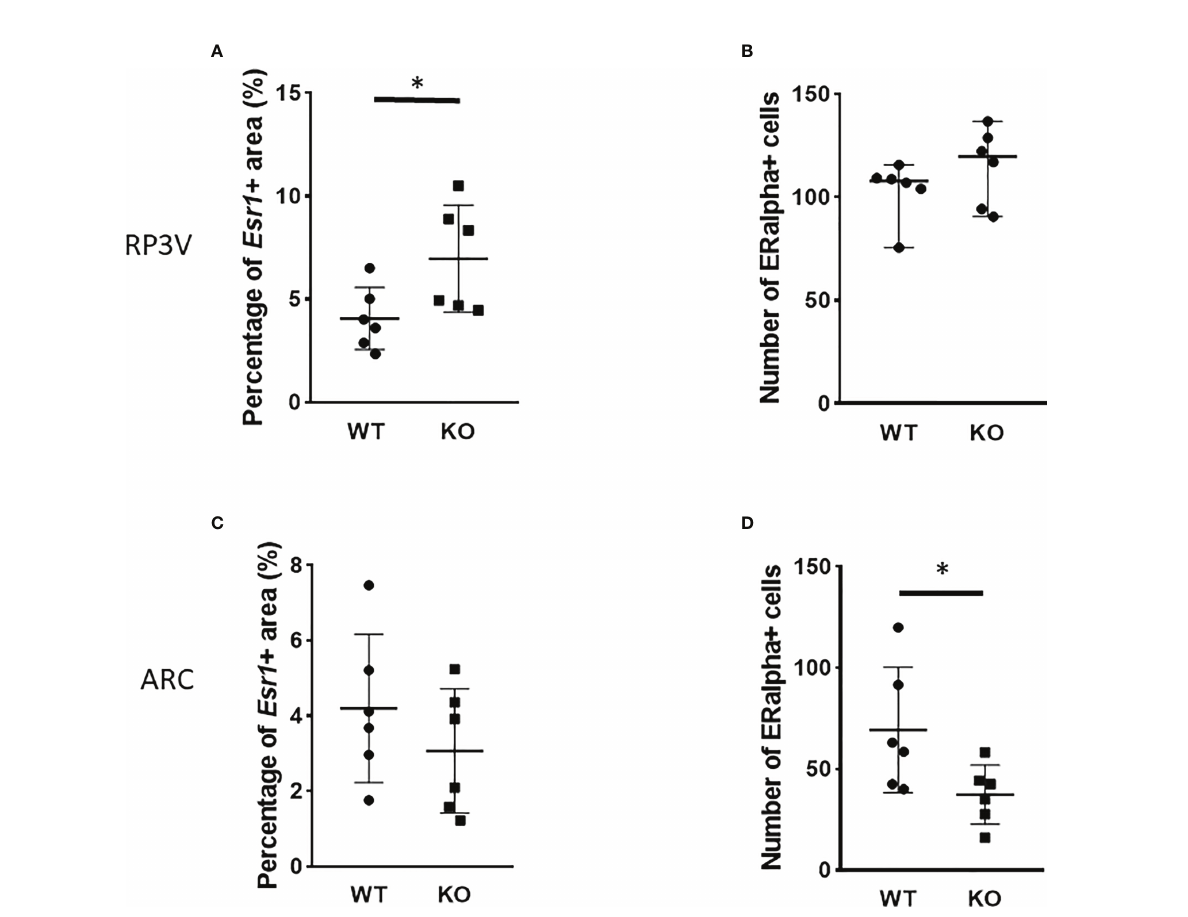
FIGURE 9 Number of ER a -immunoreactive cells in the RP3V and ARC in wild-type and PACAP KO female mice. Dot plots present the summarized data obtained by RNAscope in situ hybridization experiments showing Esr1 mRNA expression in RP3V (A) and ARC regions (C) . Immunohistochemical staining demonstrating ER a protein expression in RP3V (B) and ARC regions (D) . n = 6 – 6 animals for each group with two slices per animal. Graphs show the mean ± SD for all panels, * p <